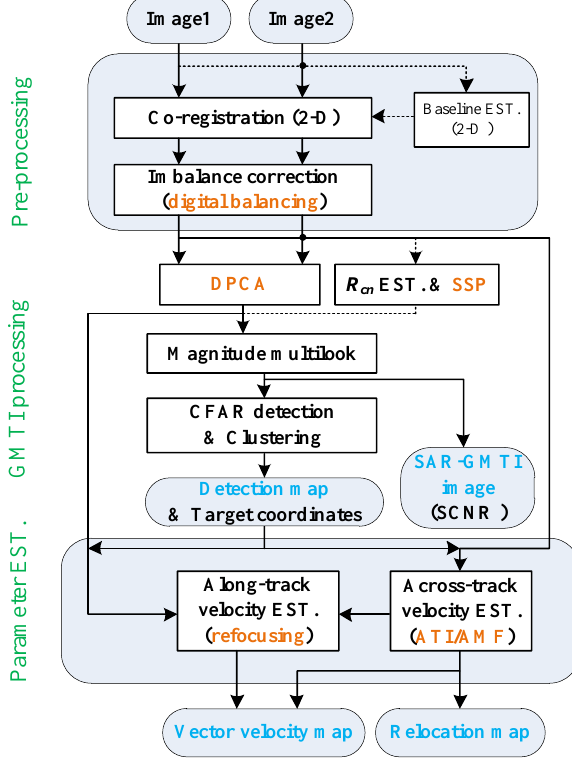
Figure 3. Workflow of the image-based SAR-GMTI processing.